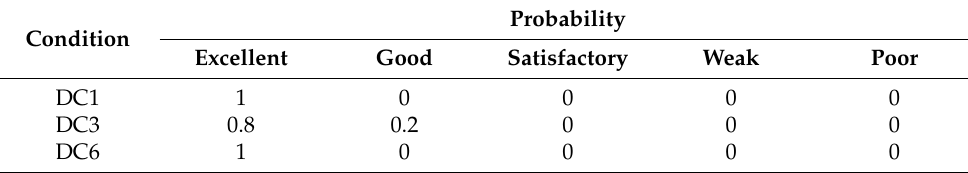
Table 6. Fuzzy relationship matrix F for part of the conditions of project 1. Condition